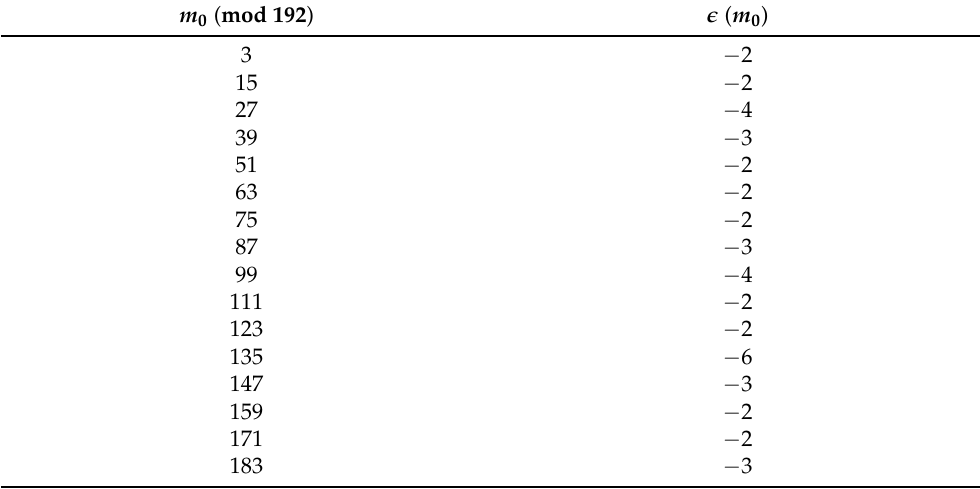
Table 3. The distribution of (cid:101) ( m 0 ) when m 0 ≡ 12 3 has periodicity 16 × 12 = 192. From m 0 = 195, it repeats itself, and will have the same (cid:101) ( m 0 ) of m 0 = 3 and